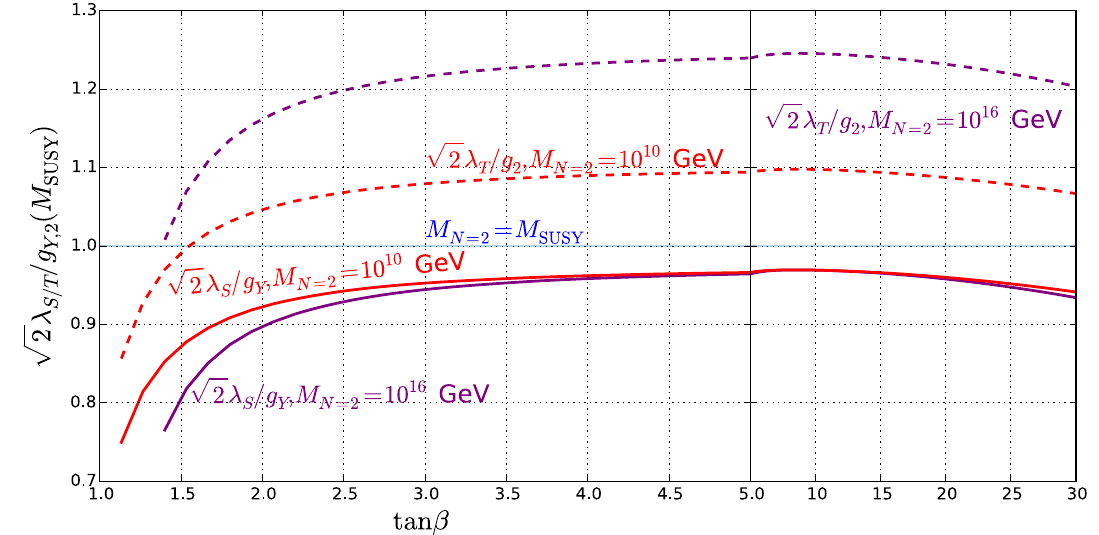
√ √ Fig. 1 Variation of the ratios 2 λ S / g Y and 2 λ T / g 2 at the scale M SUSY with tan β , for M N = 2 = M SUSY , 10 10 GeV and 10 16 GeV √ Z 1 ( M SUSY ) Fig. 2 v × against tan β for M N = 2 = M SUSY , 10 10 GeV and 10 16 GeV, which corresponds to the “tree-level” value of the Higgs mass before we take running from M SUSY (or equivalently the SUSY corrections at M Z ) into account (we take v = 246 GeV in the figure). We see that increasing M N = 2 increases the Higgs mass, particularly for small tan β > 1 .